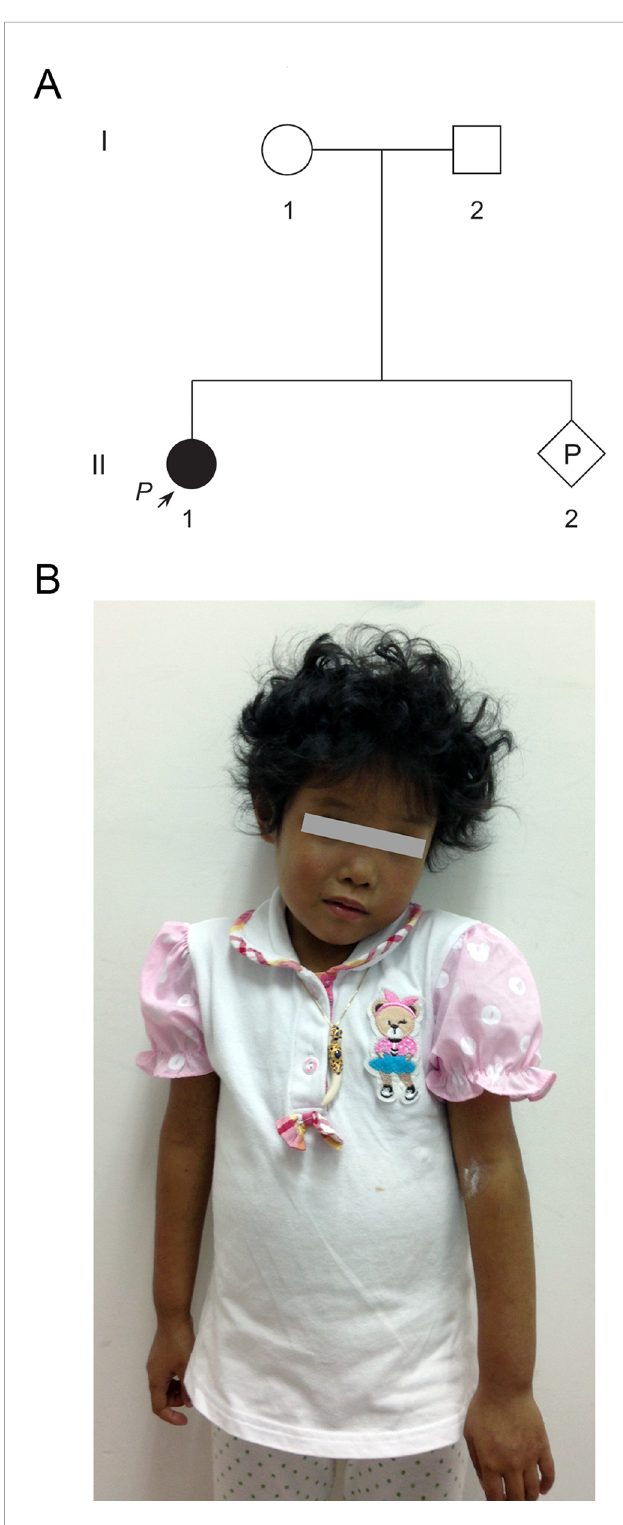
FIGURE 1 | Pedigree of a Chinese family at-risk for recurrence of Alagille syndrome (ALGS). (A) Arrow indicates the proband. All family members were subjected to genetic analysis. (B) The proband was presented with jaundice skin and curly